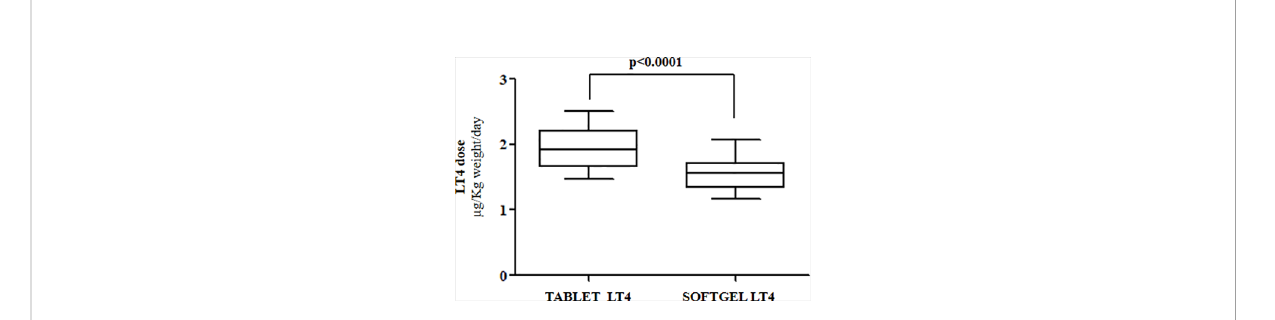
FIGURE 3 Median LT4 requirement in patients with gastric juice pH>2 (Group B) before and after the switch to softgel formulation.